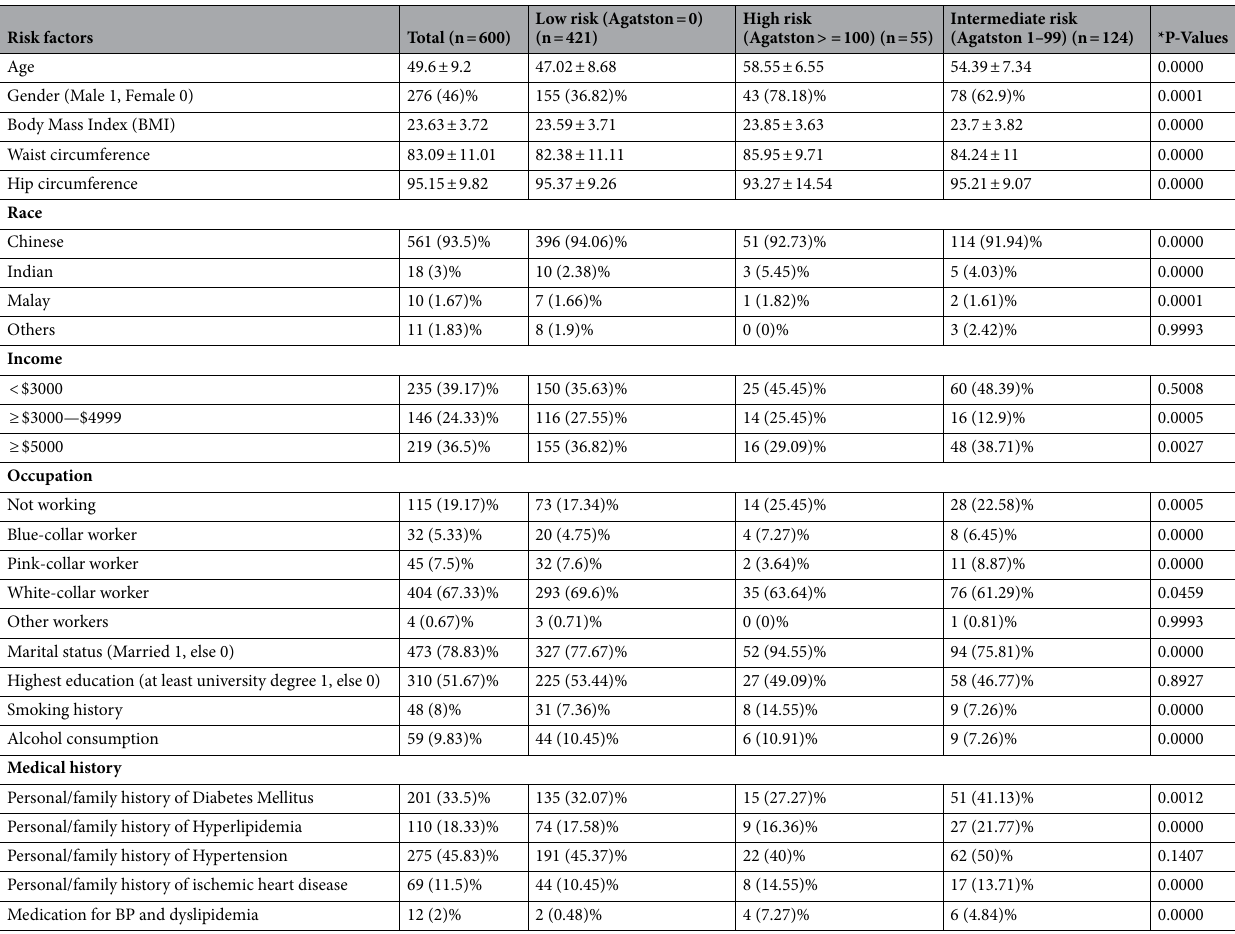
Table 2. Demographics by risk